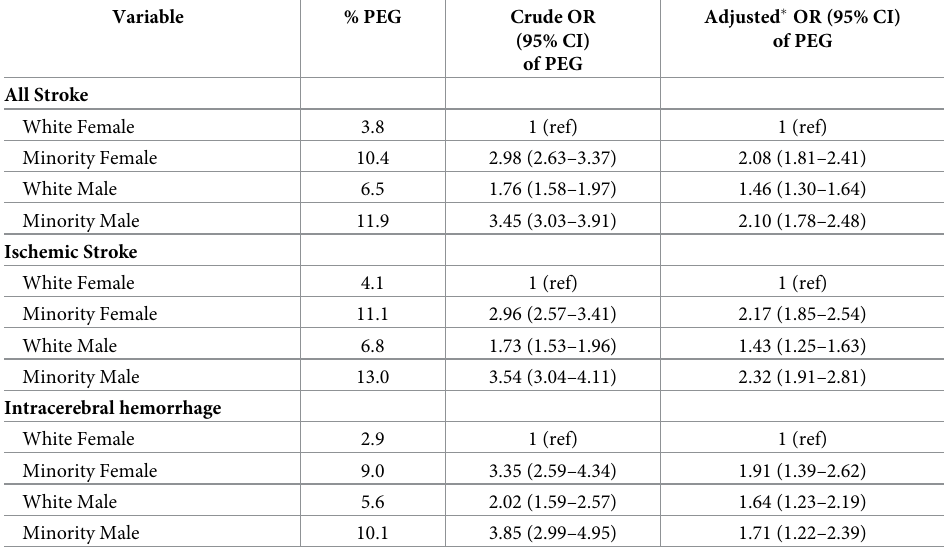
Adjusted (cid:3) OR (95% CI) (95% CI) of PEG of PEG